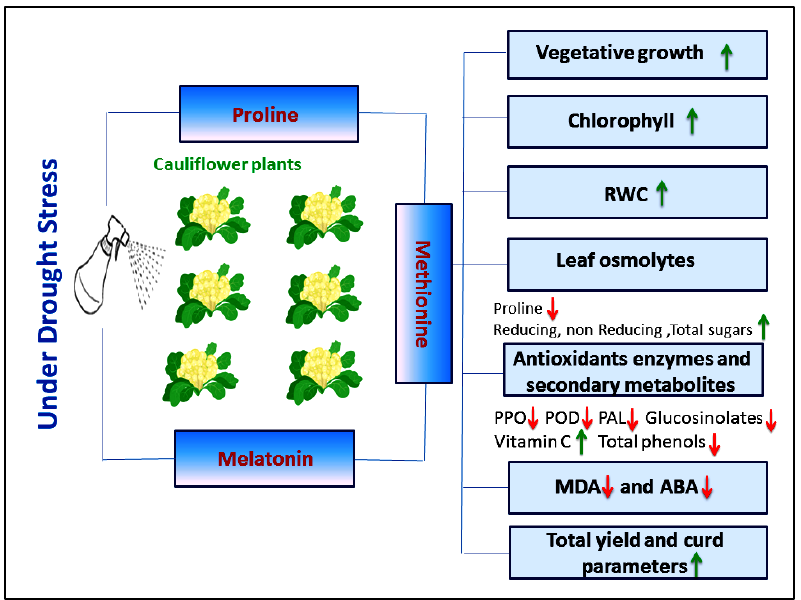
Figure 4. Simplified conclusion for the suggested effect of proline, methionine, and melatonin application as a foliar spray on the growth and bioactive compounds of cauliflower plants grown under drought stress.